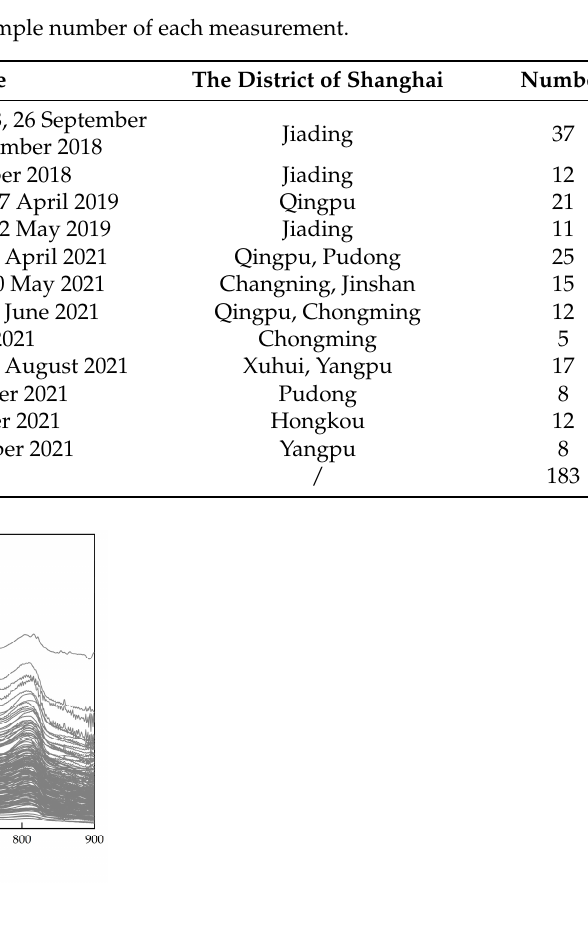
Figure 2. In situ measured R rs .